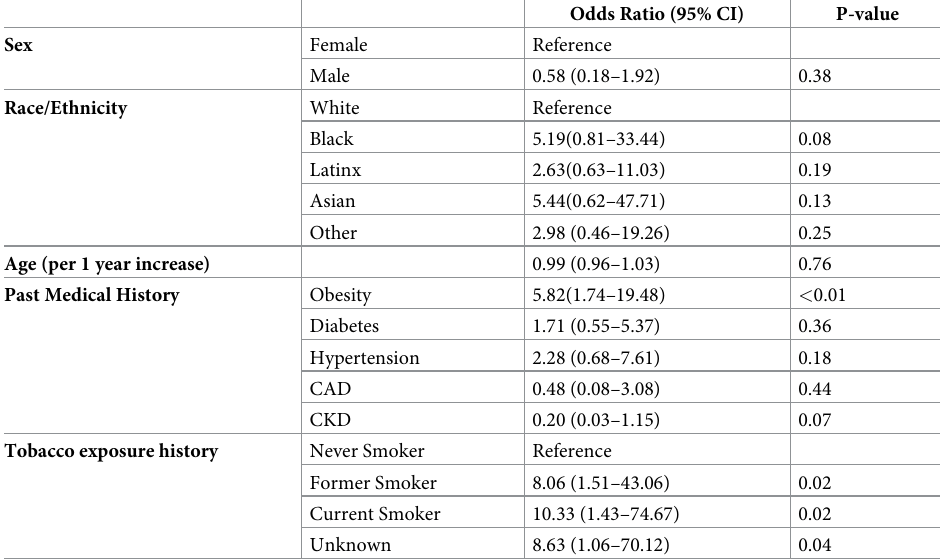
Table 3. Multivariable logistic regression for odds of requiring mechanical